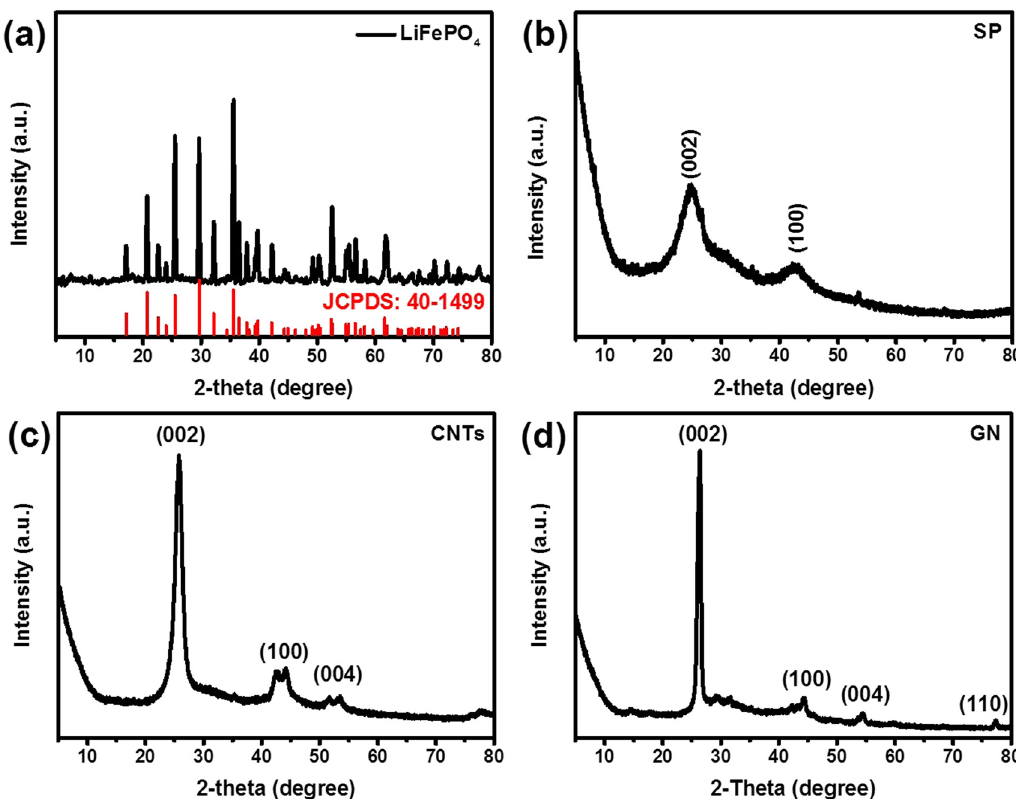
Figure 1: XRD patterns of LiFePO 4 ( a ) , SP ( b ) , CNTs ( c ) , and GN ( d )